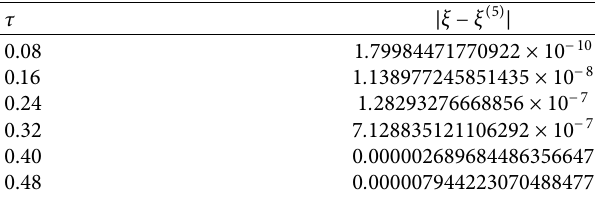
1 with ] 0 . (cid:29) (cid:29)